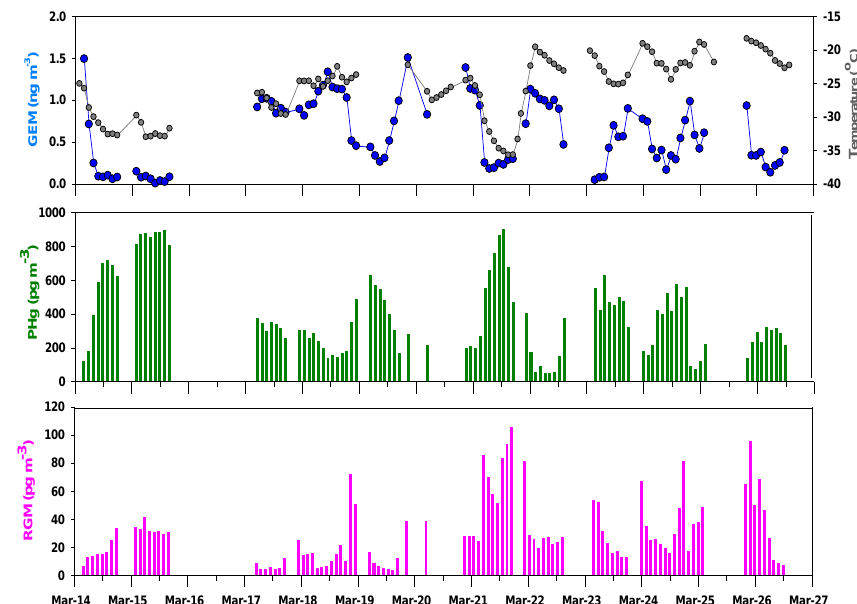
Fig. 2. Hourly speciation and air temperature data from over the ice. Gaseous elemental mercury (GEM, top) is reported in ngm − 3 , and reactive gaseous mercury (RGM, bottom) and particulate mercury (PHg, middle) are reported in pgm − 3 . Air temperature is reported in ◦ C. The gaps in data indicate when the system was moved to a new site or when the power